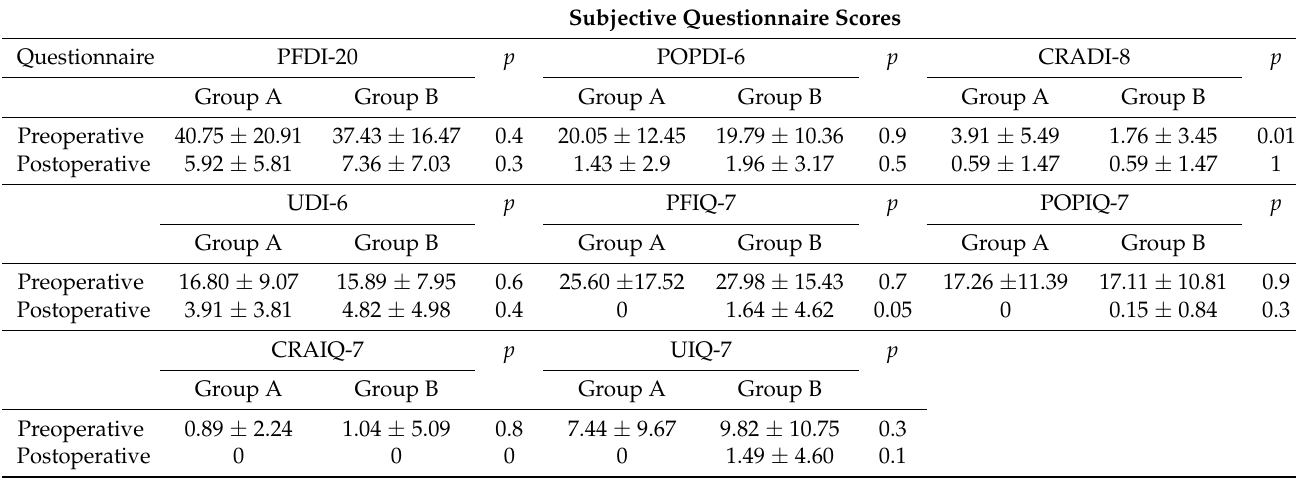
Table 4. Subjective questionnaire scores at baseline and postoperative points. Subjective Questionnaire Scores